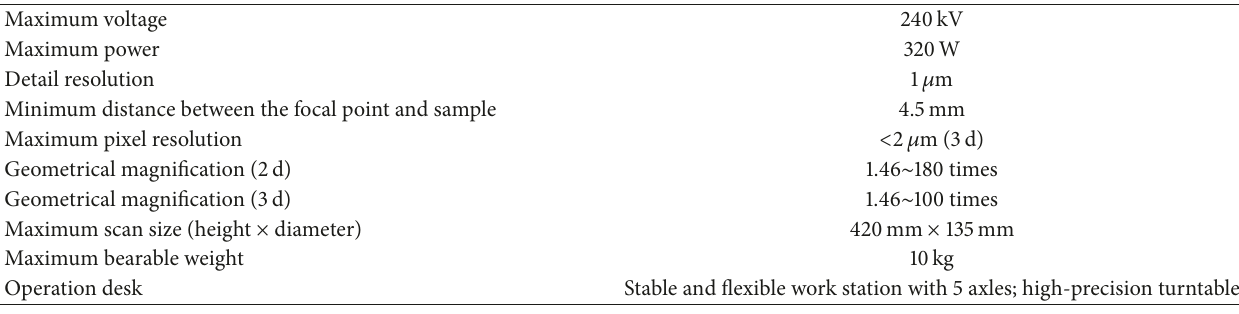
Table 4: Specification parameters of the X-ray computed tomography.